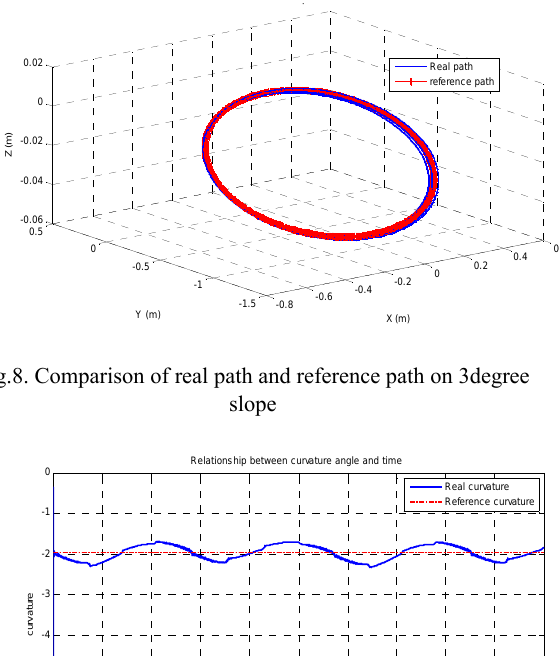
Fig.7. Comparison of real curvature and reference curvature on 3degree slope